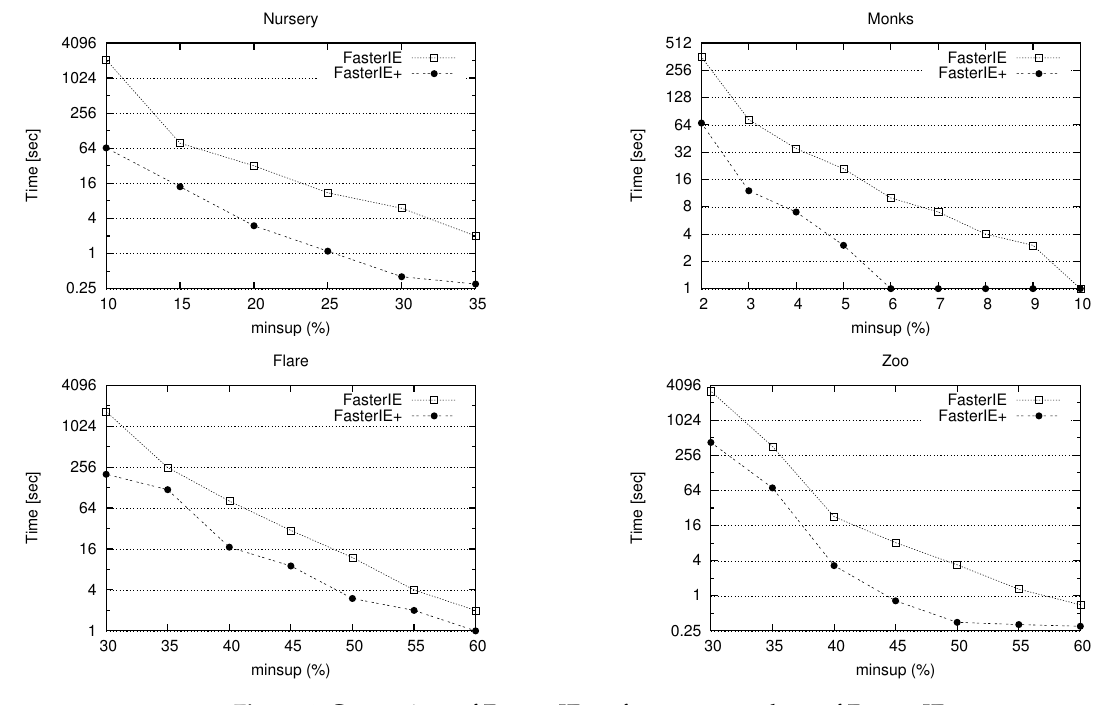
Figure 4. Comparison of F ASTER IE performances vs. those of F ASTER